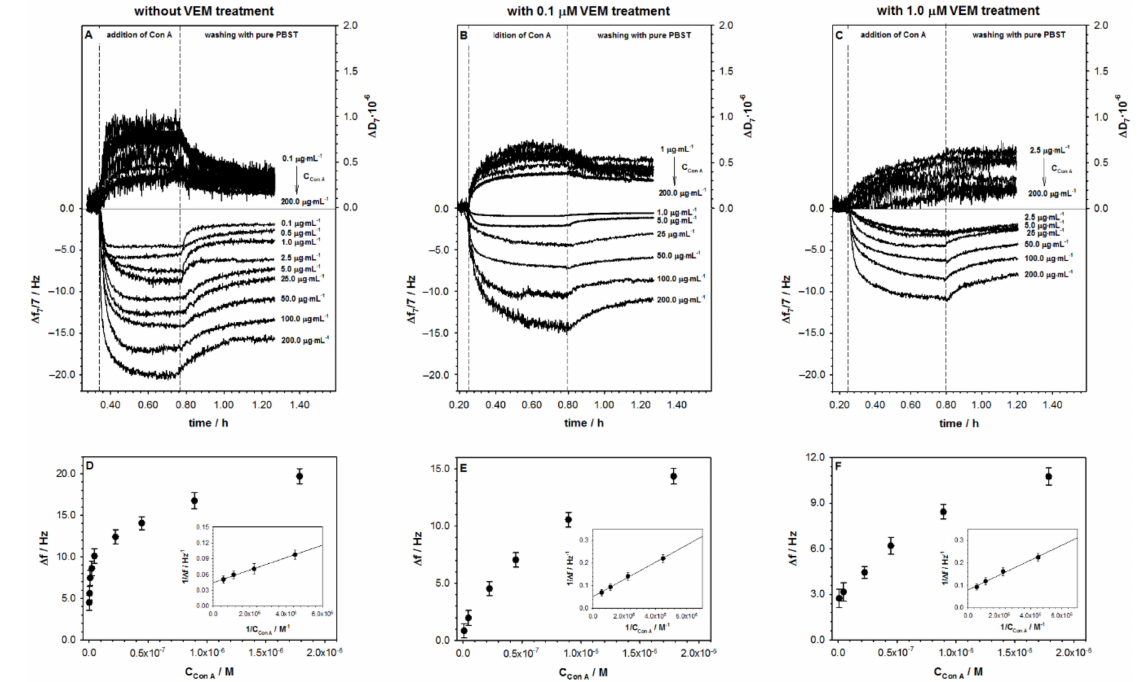
Figure 2. ( A ) Typical QCM-D spectra of the shifts in frequency ( ∆ f ) and dissipation factor ( ∆ D ) recorded during covalent binding of Con A to AGP without, and ( B , C ) with VEM treatment; ( D ) saturation binding curves for Con A to AGP untreated and ( E , F ) treated with vemurafenib and their respective reciprocal curves (insets). Experimental conditions: PBST buffer with the addition of 1% DMSO.